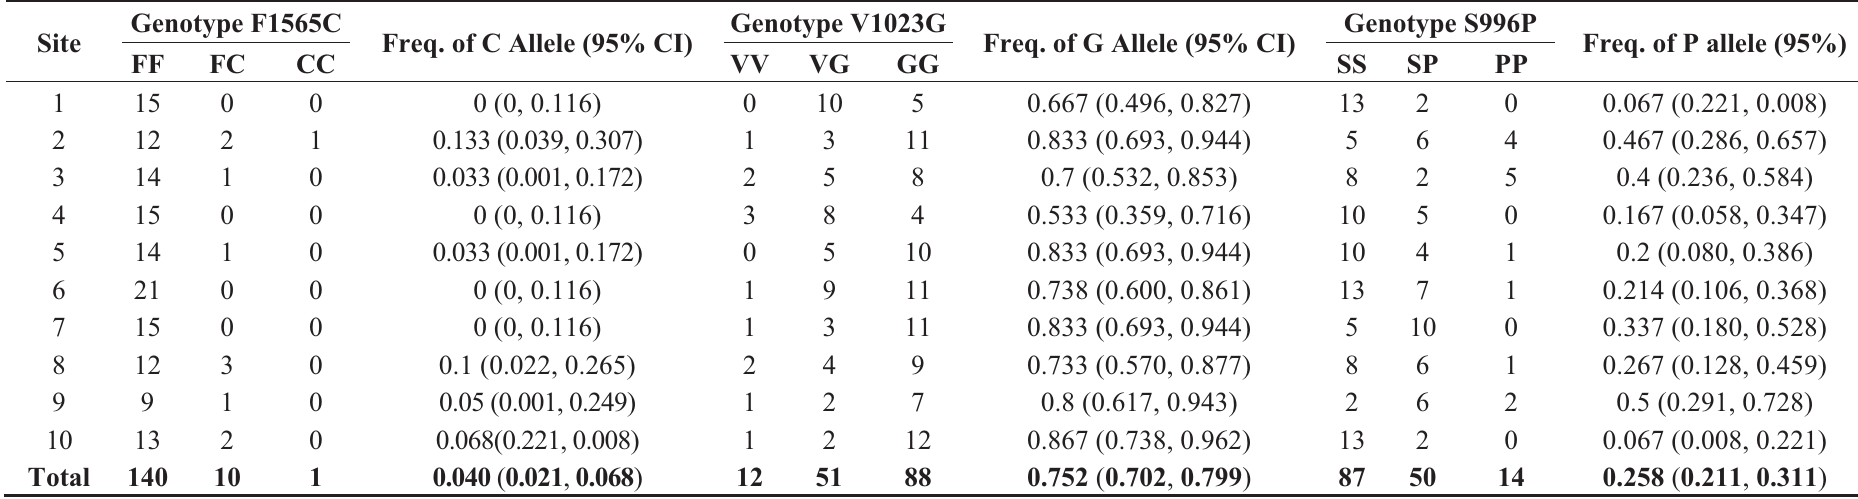
Table 2. HRM assay results for Vssc F1565C, V1023G and S996P mutations of Aedes aegypti from Yogyakarta Season 1.